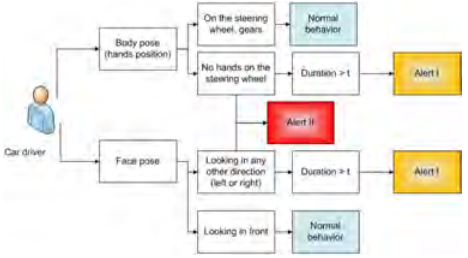
Figure 7. Architecture of a digital car driver system.